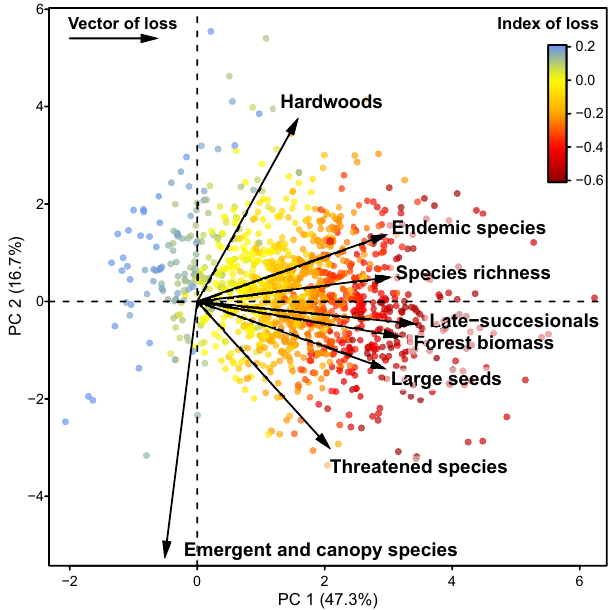
Fig. 3 Human-induced impacts on tree species richness, multiple species properties, and forest biomass. Two-dimensional representation of the standardized indices of loss for each forest survey (points, n = 1154) plotted on the two fi rst principal component (PC) axes, which explain 64% of the variation in the indices of loss. Arrows and their length represent the vectors of loss, i.e. the direction and strength of each individual index of loss. The more aligned the arrows, the more correlated the indices are. The average of all indices of loss is highlighted by a colour scale for each survey ranging from dark red (high losses) to blue